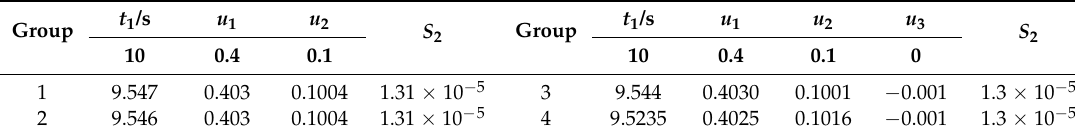
Table 4. The identified parameters by simple shear